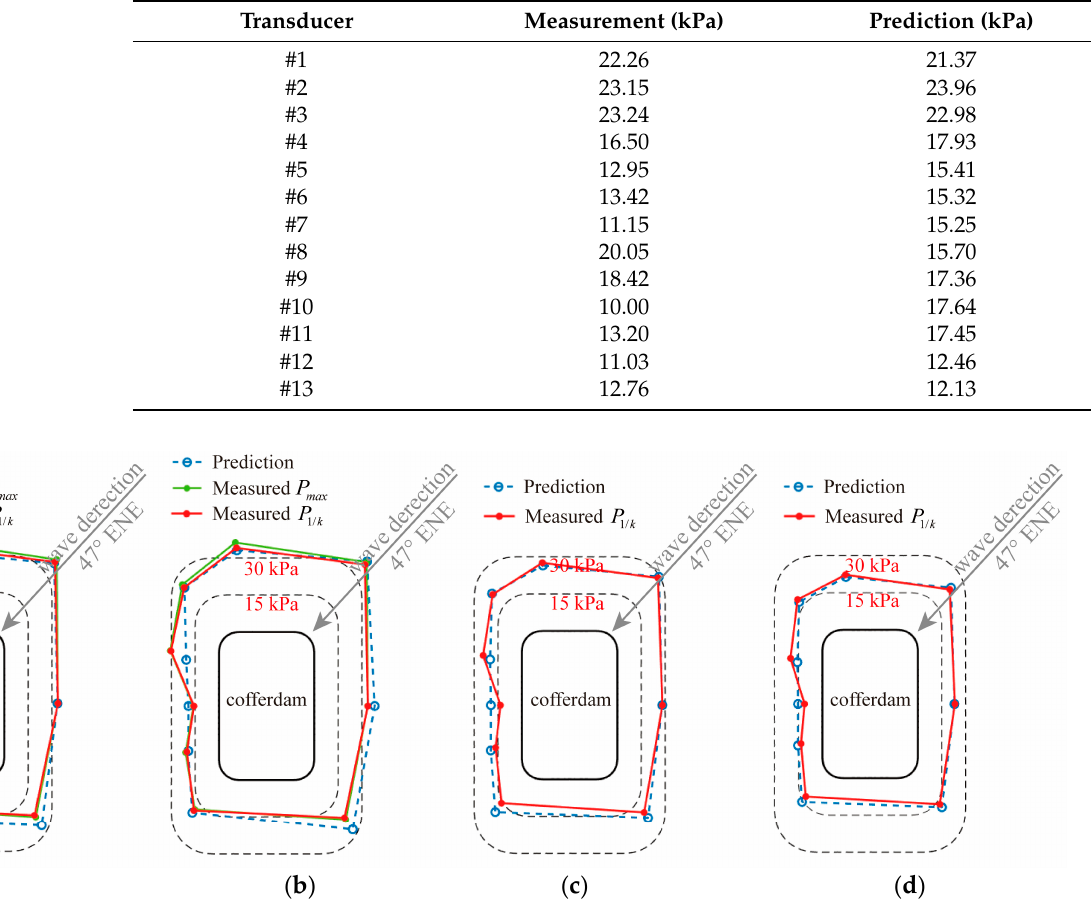
P ) and prediction (